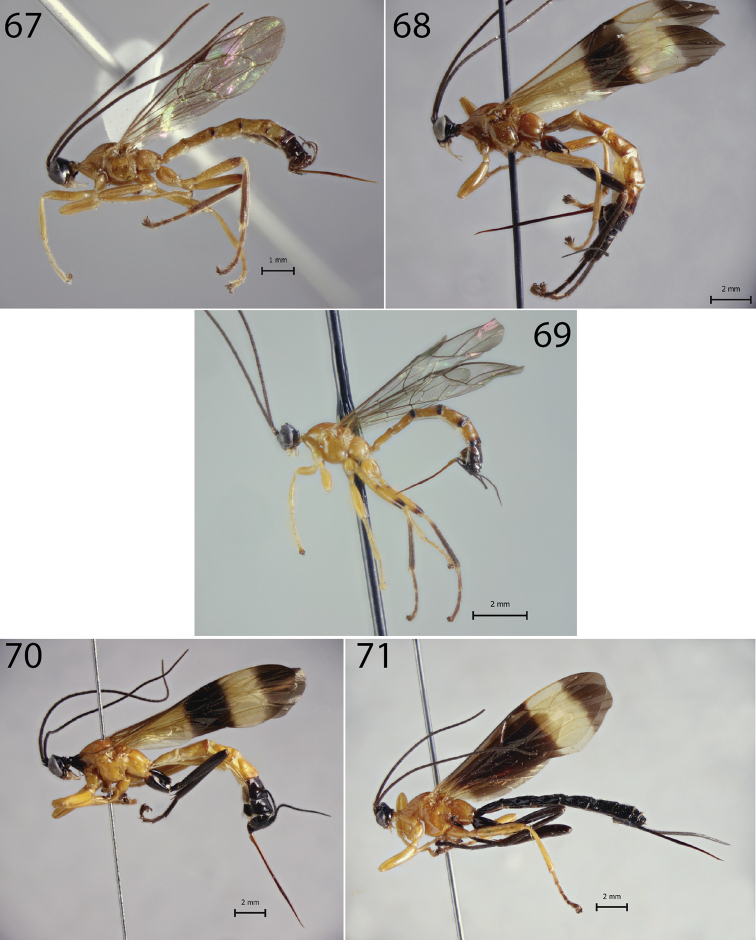
Habitus of Hymenoepimecis spp. (females), lateral view 67H.
kleini68H.
longilobus sp. nov. (holotype) 69H.
manauara70H.
neotropica71H.
pucallpina sp. nov. (holotype).